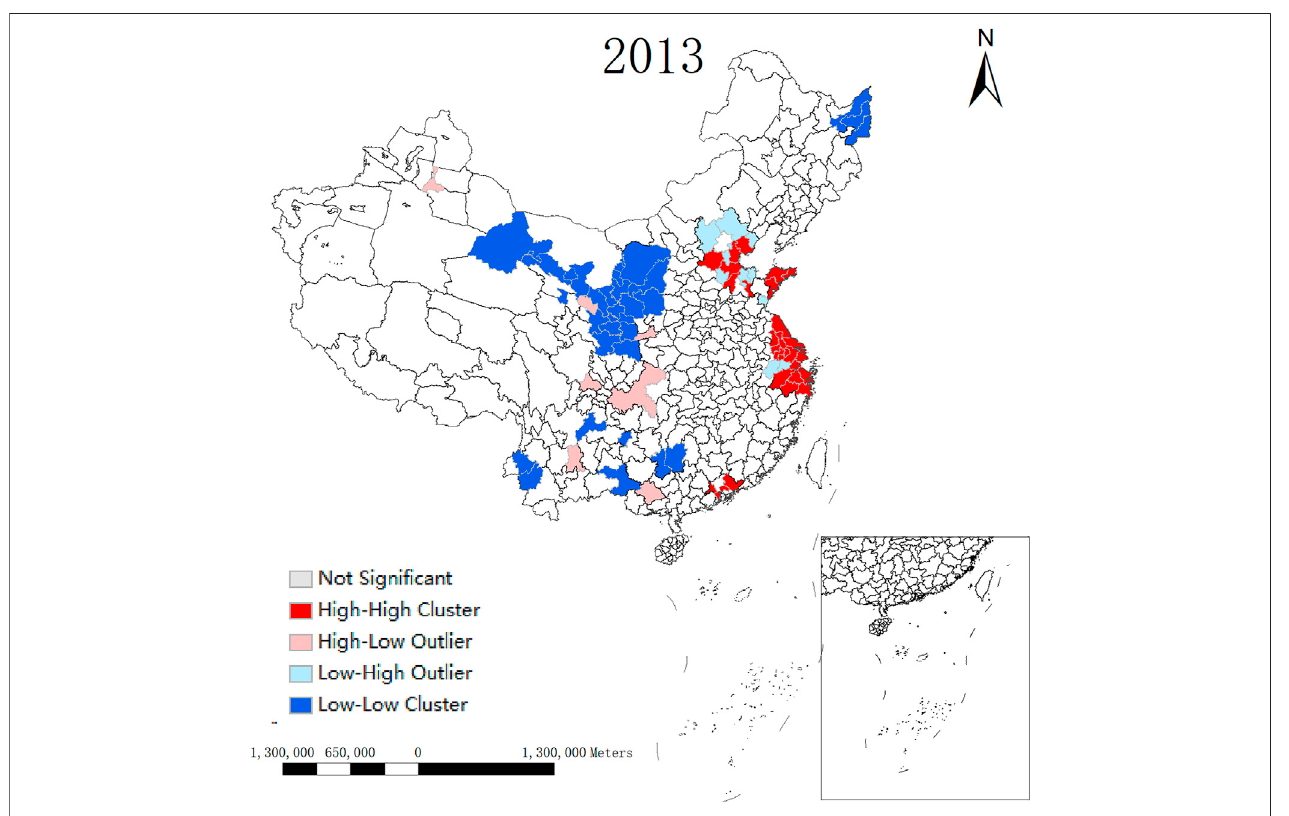
FIGURE 4 | Spatial correlation distribution of urban consumption in